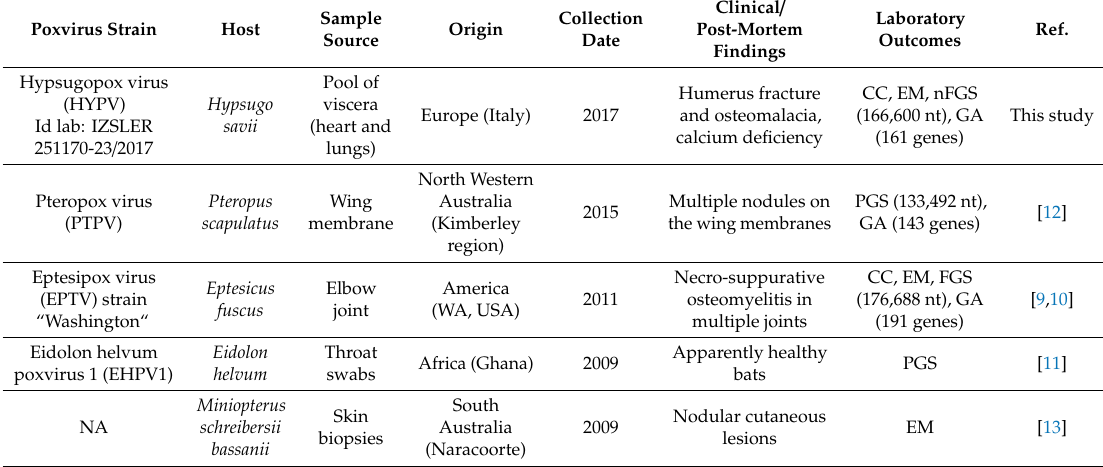
Table 1. Basic data on Hypsugopoxvirus (HYPV) in comparison with all known poxviruses detected to date in bats worldwide.